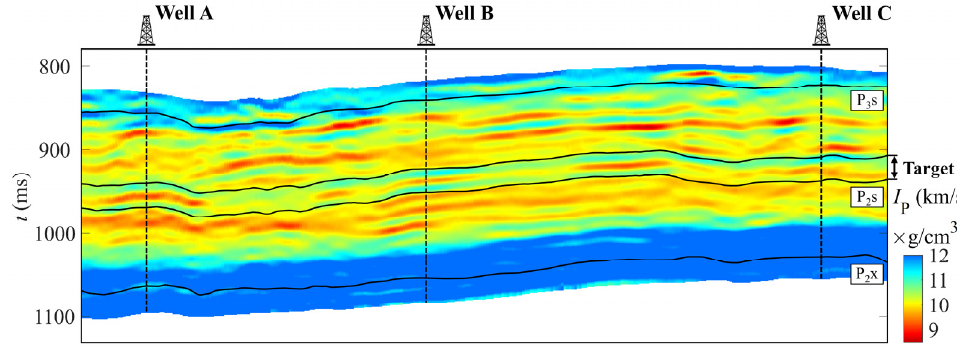
Figure 14. Seismic section of I P across wells A, B, and C.